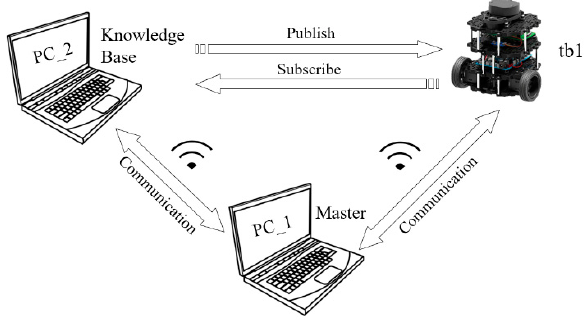
Figure 16. The communication among different devices.